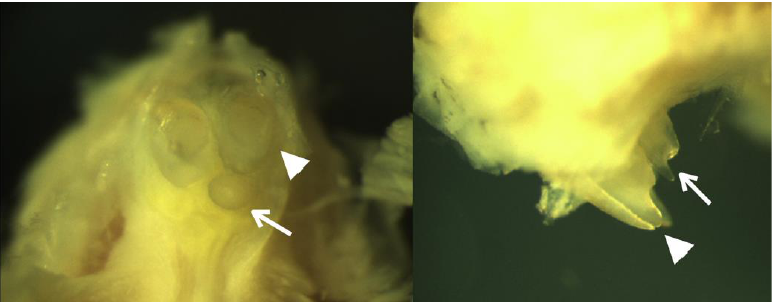
Figure 6. Lrp4 mutant mice. Arrowheads indicating endogenous incisors, while arrows indicating supernumerary incisors.